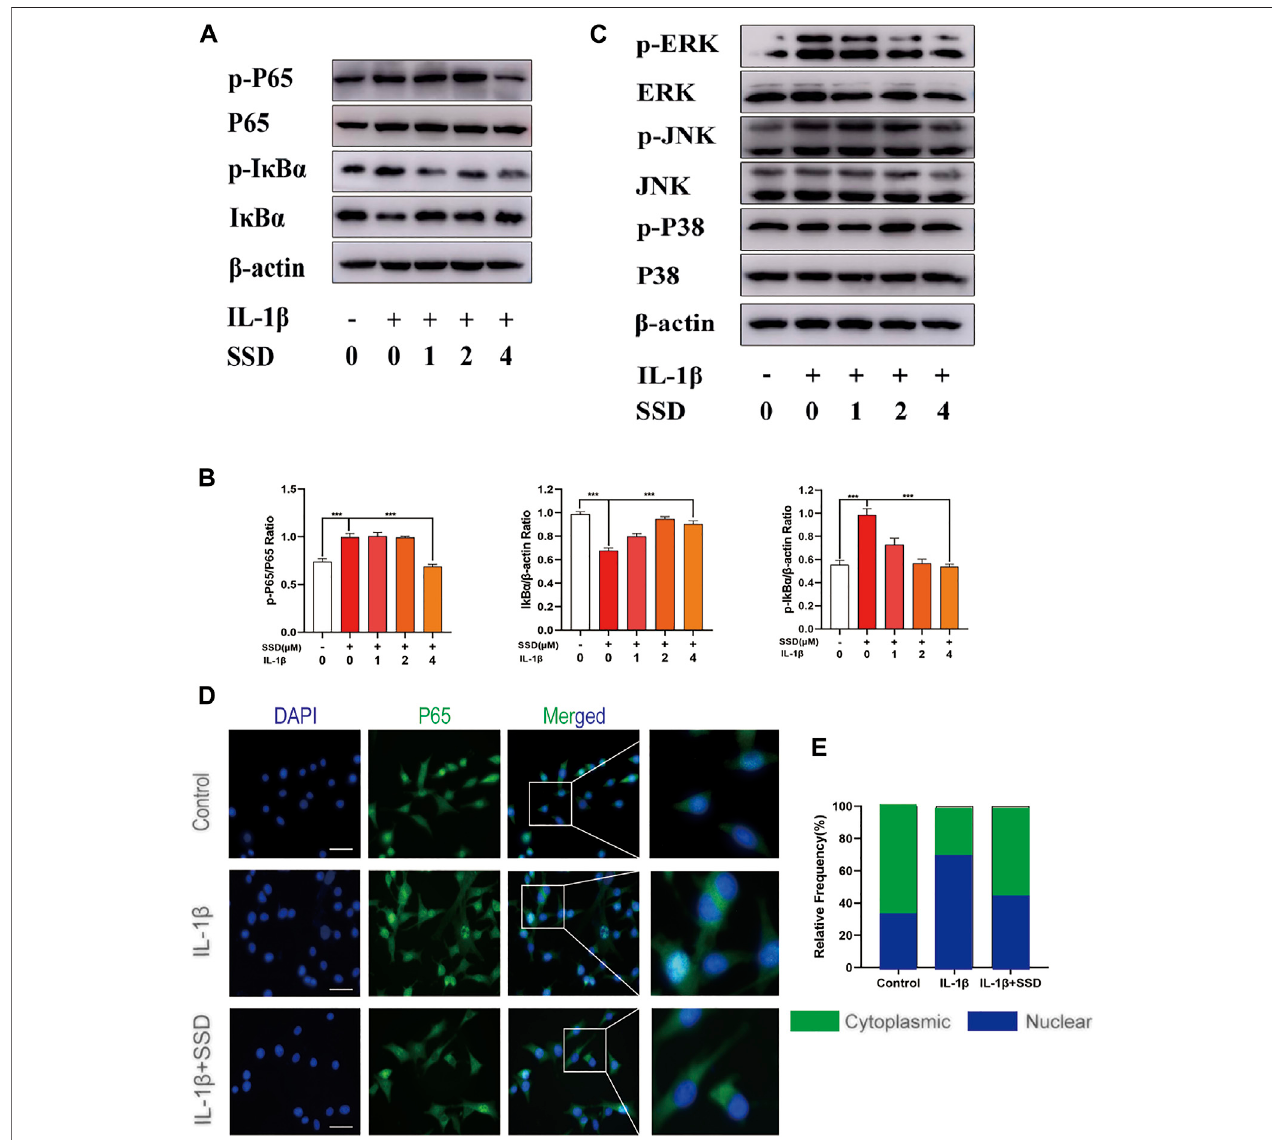
FIGURE 6 | Inhibition of SSD on the NF- κ B signaling pathway. (A) SSD prevented I κ B α from being degraded and inhibited the phosphorylation level of p-P65 and p-I κ B α . (B) Above protein expression level was quanti fi ed using ImageJ. (C) SSD had no effects on Mapks signaling pathway – related proteins including P38, p-P38, ERK, p-ERK, JNK, and p-JNK. (D) Immuno fl uorescence was conducted to detect the P65 nuclear translocation. (E) The quanti fi cation of P65 fl uorescence intensity (original magni fi cation, ×200; scale, 15 μ m). Mean ± SD was applied with all data. The experiments in vitro were performed independently at least 3 times. *** p < 0.001, ** p < 0.01, * p <